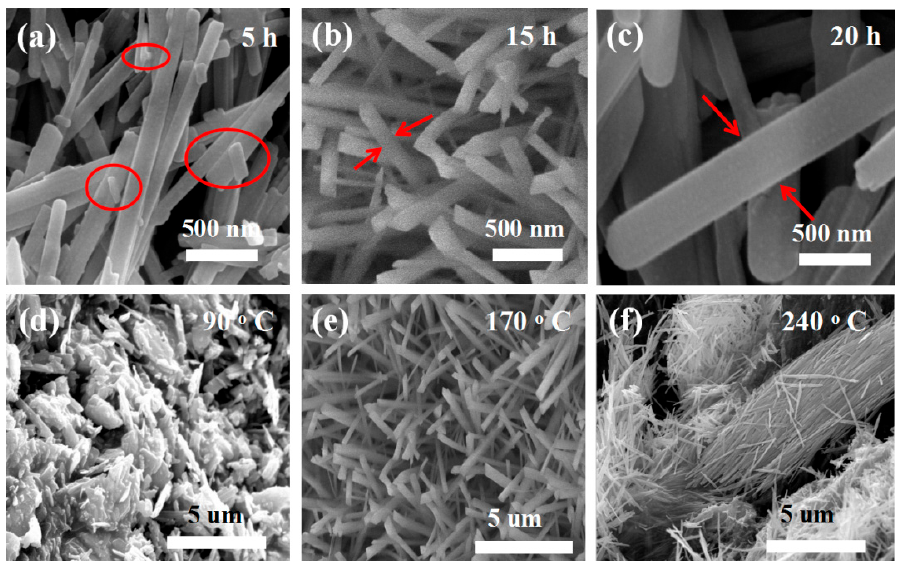
Figure 3. Growth control of the product morphology. ( a – c ) SEM images of the product with the reaction time 5 h, 15 h and 20 h at the same reaction temperature 170 °C; ( d – f ) SEM images of the product with the reaction temperature 90 °C, 170 °C and 240 °C at the same reaction time 15 h, respectively.